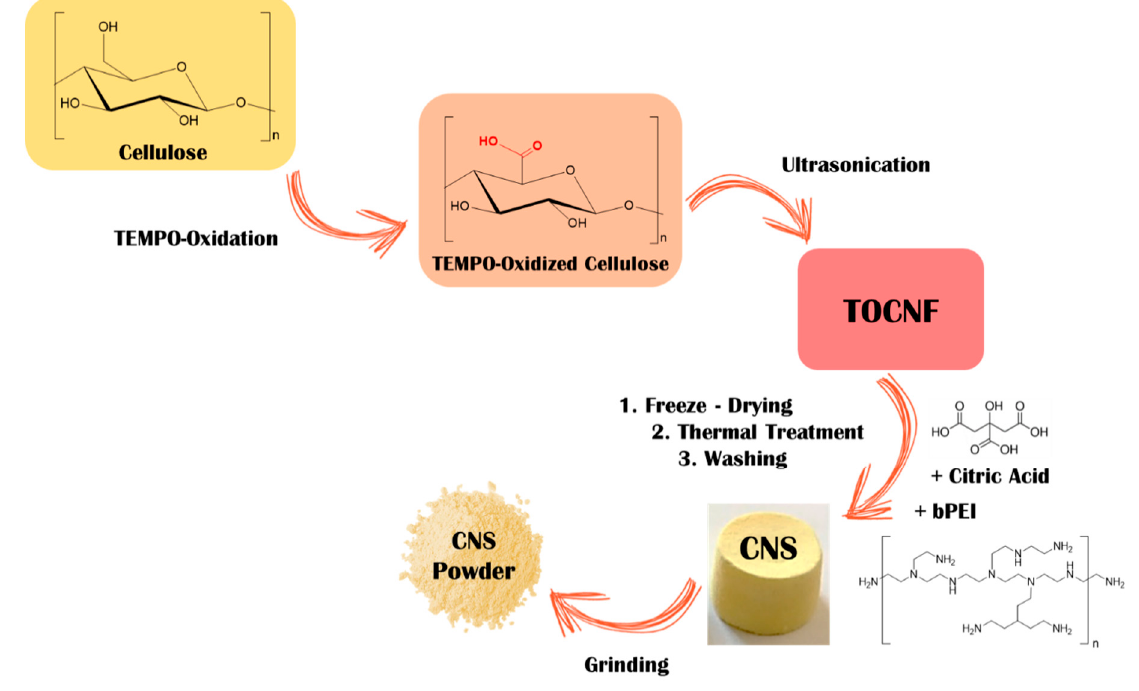
Figure 3. Synthesis of cellulose-based nanosponges Figure 3 . Synthesis of cellulose-based nanosponges (CNS).